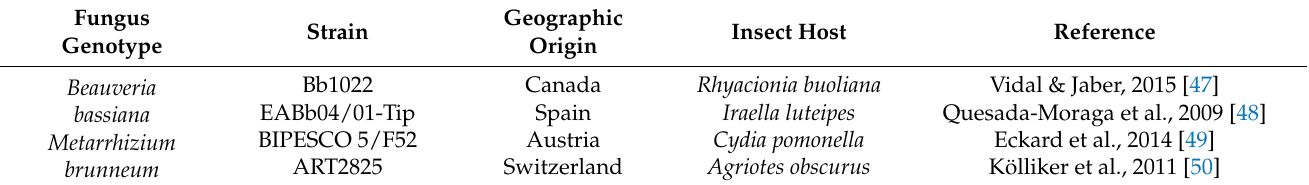
Table 1. Isolates of entomopathogenic fungi used in this study with geographic origin, original insect